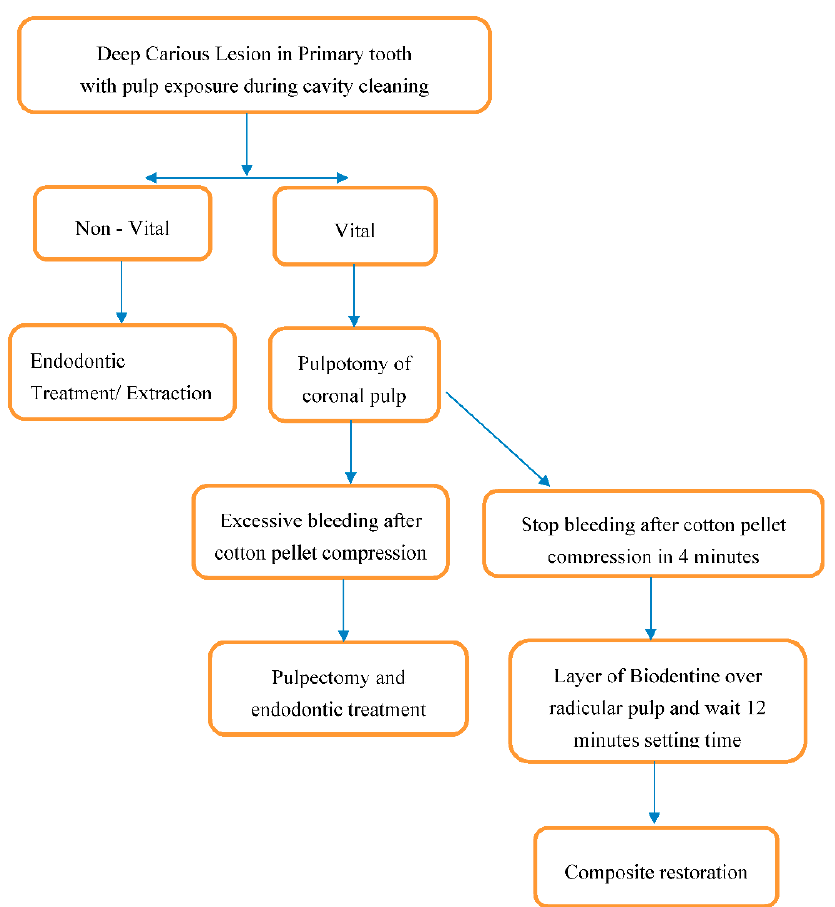
Figure 1. Flowchart summarizing the decision process and the clinical phases of the pulpotomy procedure.